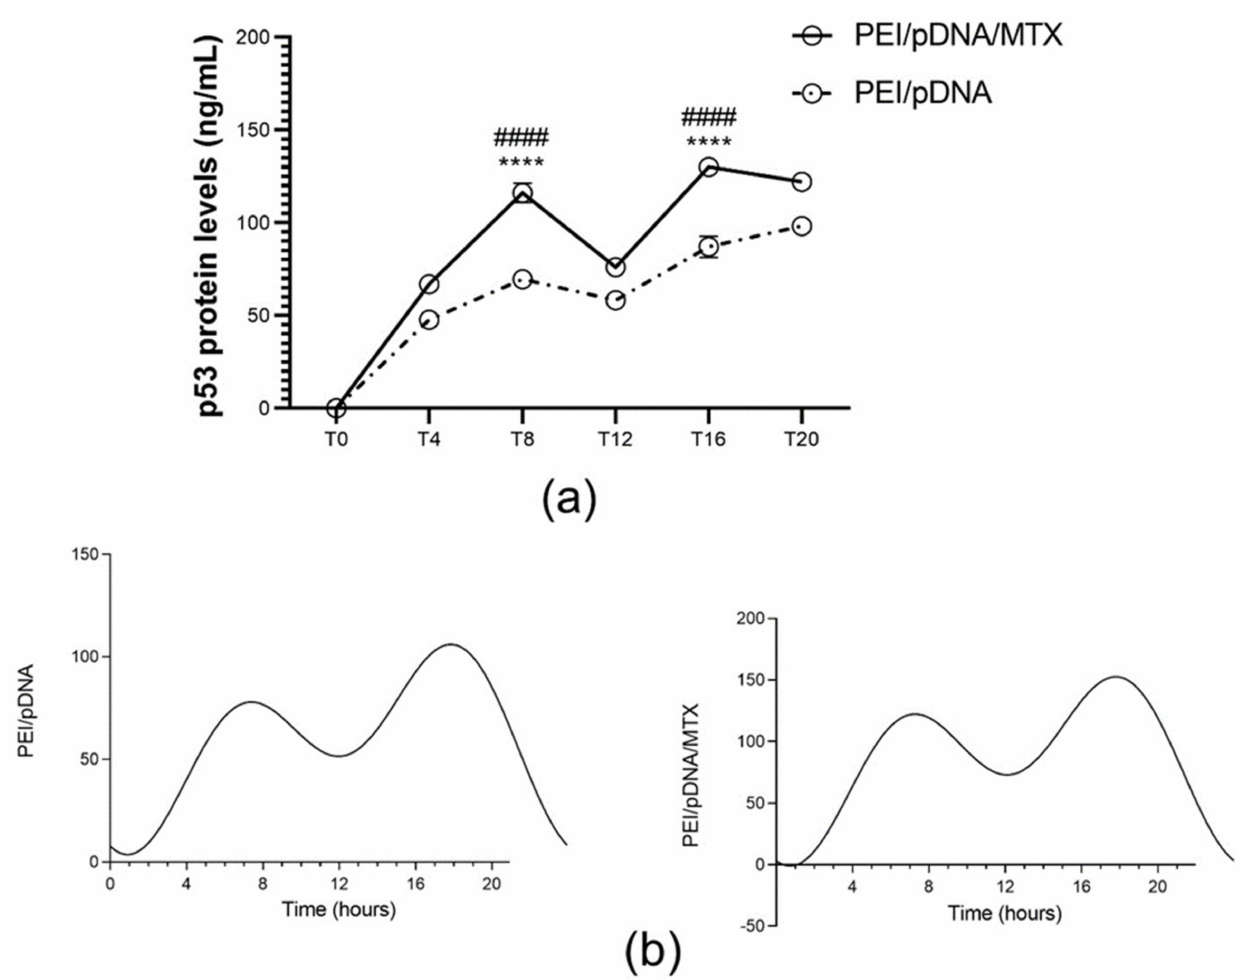
Figure 10. Quantification of p53 protein levels (ng/mL) for each time point. ( a ) p53 protein levels have been determined 48 h after transfection mediated by PEI/pDNA and PEI/pDNA/MTX nanoparticles by using the p53 pan ELISA kit. Each data point represents the mean ± SD (n =3) and were analyzed by two-way ANOVA with the Bonferroni test. At time T8 and T16, substantial levels of protein were found in fibroblasts, in comparison to other time points (**** p < 0.0001). Additionally, the difference between PEI/pDNA and PEI/pDNA/MTX is statistically significant for T8 and T16 (#### p < 0.0001). ( b ) Circadian oscillations are statistically significant as analyzed with CircWave ( p < 0.0001 for both PEI/pDNA and